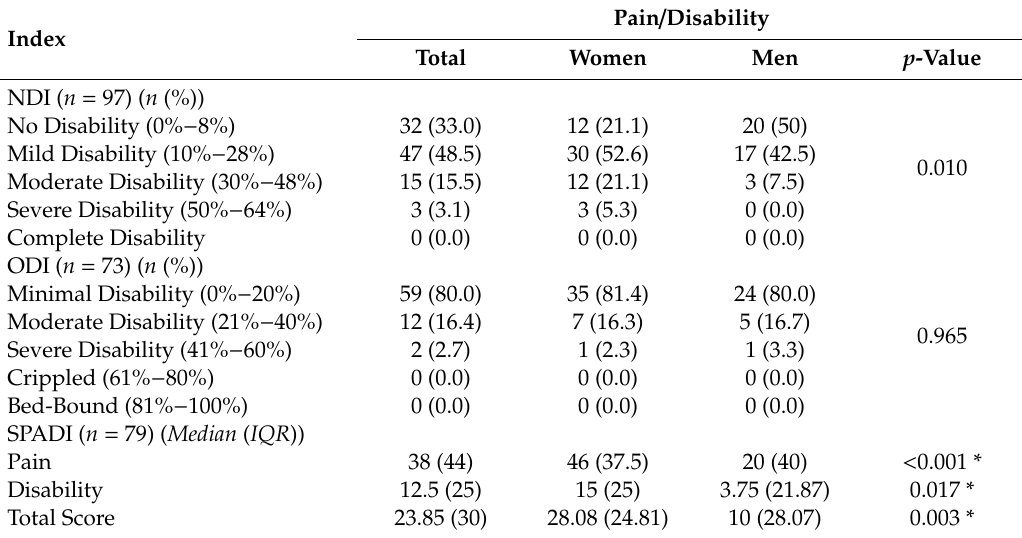
Table 6. Disability of symptomatic participants and comparison by gender.